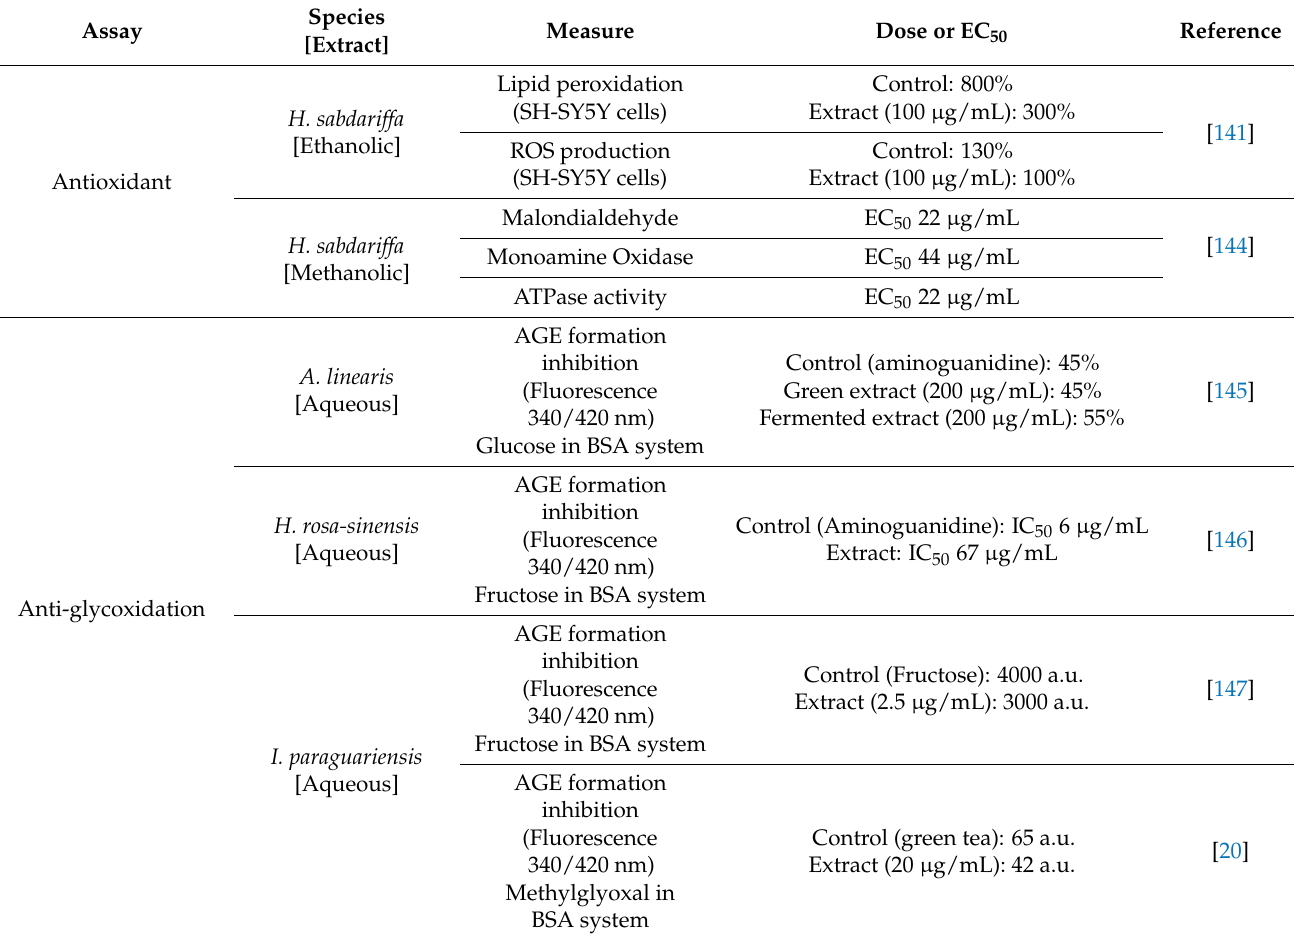
Table 3. In vitro antioxidant and anti-glycation effects of rooibos, hibiscus, yerba mate